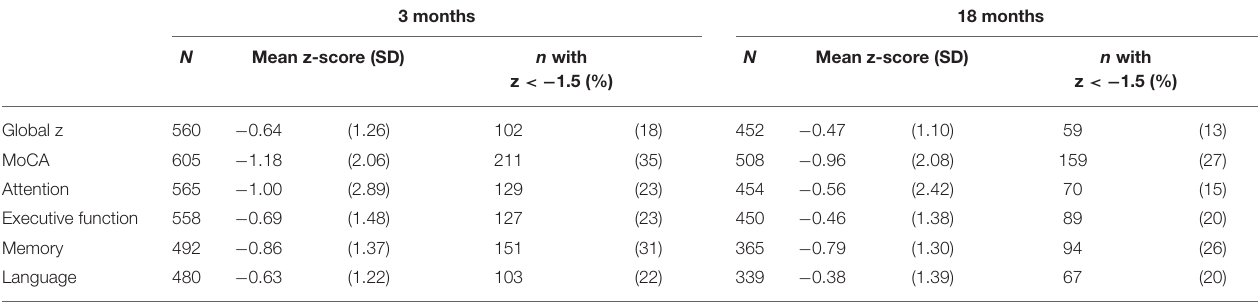
TABLE 2 | Patients’ performance on the global measures and cognitive